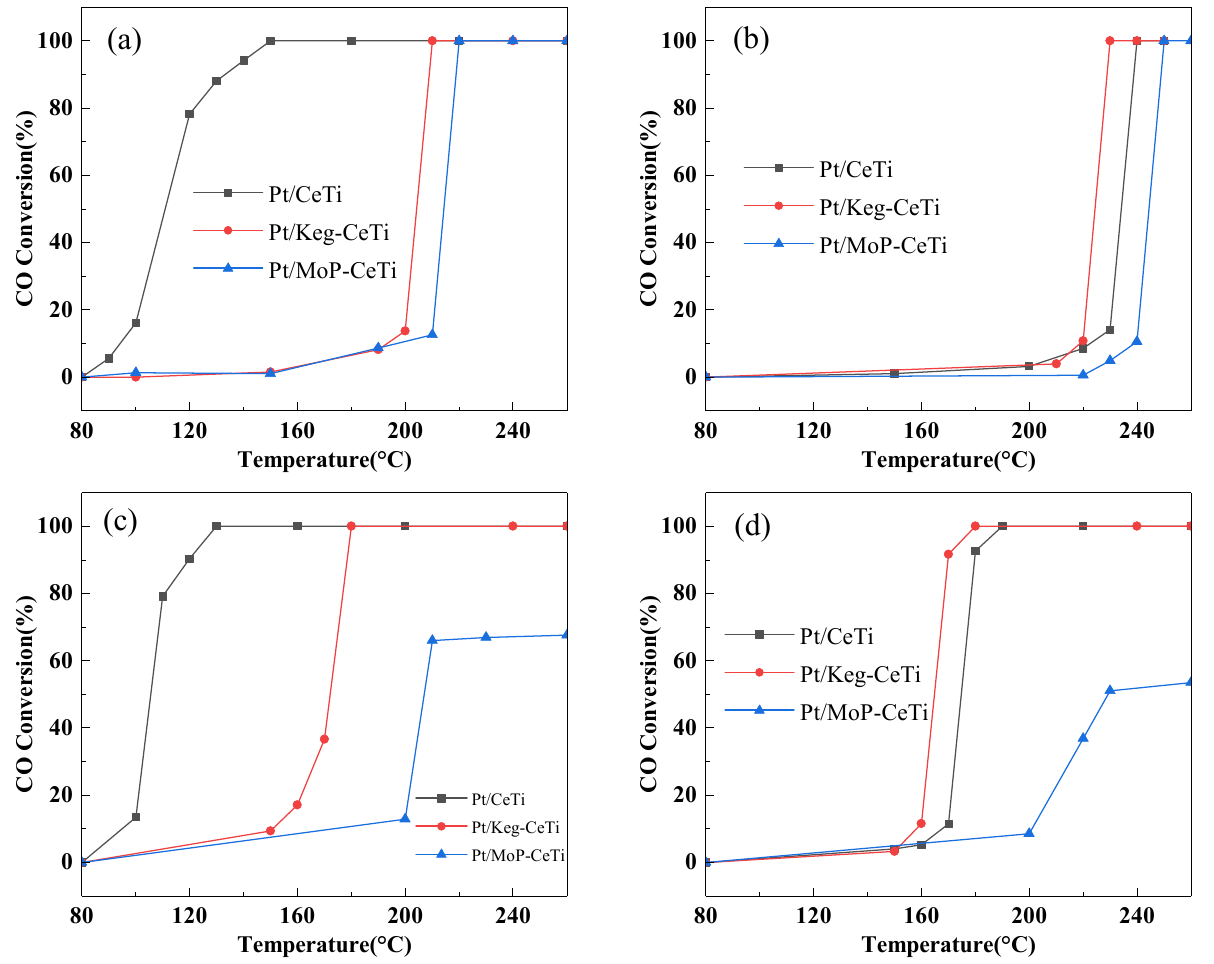
Figure 1. CO conversions as a function of reaction temperature over the Pt/CeTi, Pt/Keg-CeTi, and Pt/MoP-CeTi catalysts in the absence of H 2 O and SO 2 ( a ), and in the presence of SO 2 ( b ), H 2 O, ( c ) or both H 2 O and SO 2 ( d ), respectively. Reaction conditions: [CO] = 1%, [O 2 ] = 6 vol%, [H 2 O] = 10% (when used), [SO 2 ] = 100 ppm (when used), balance He, total flow rate = 667 mL/min, GHSV = 4 × 10 5 h − 1 .